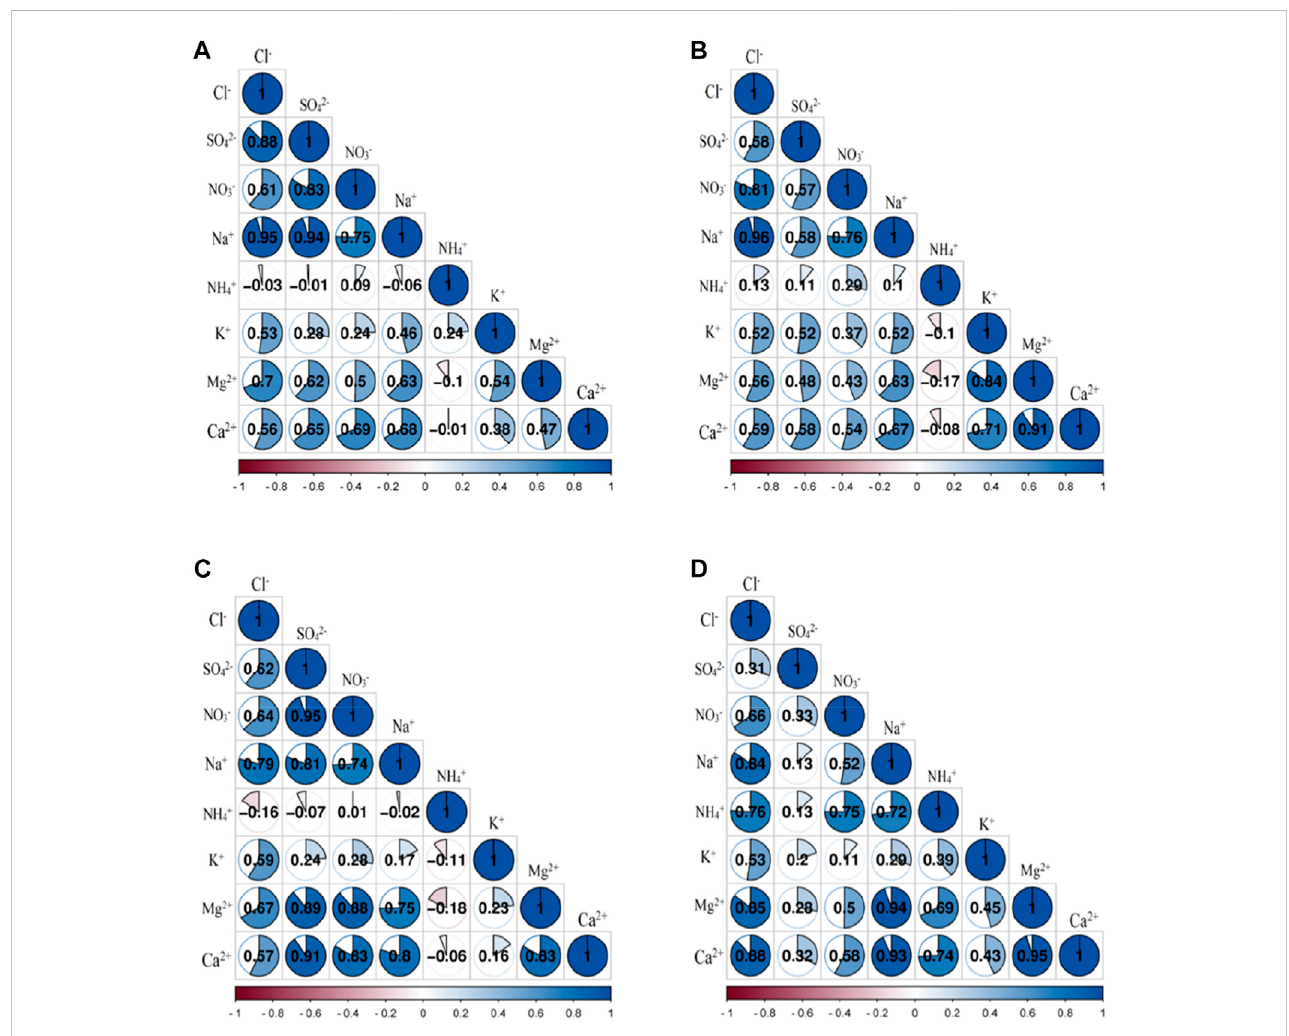
FIGURE 12 Correlation analysis of main inorganic ions insnowpack inthe study area, where (A,B) are thecorrelation analysis ofions in 2018/2019 and 2019/2020 in Heihe region, and (C,D) are the correlation analysis of ions in 2018/2019 and 2019/2020 in Altay region,